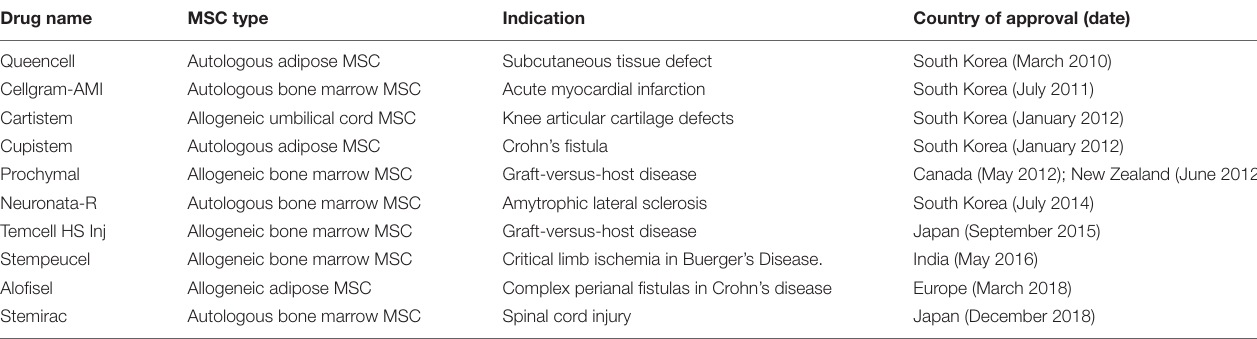
TABLE 1 | List of regulator-approved MSC therapeutic